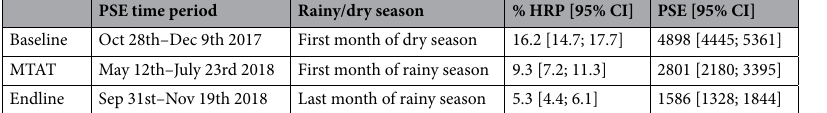
Table 2. Results for the population-based household survey method for population size estimation of HRP